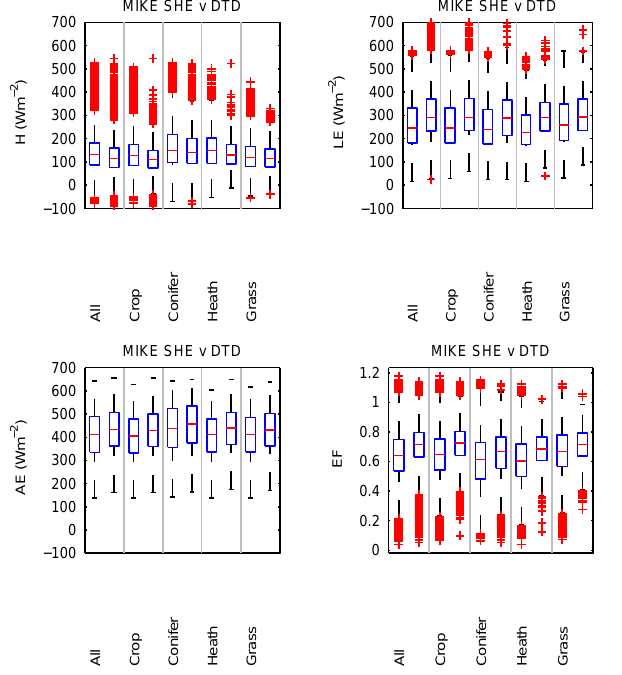
Figure 8. Box plots of sensible heat flux (top left), latent heat flux (top right), net radiation (bottom left) and evaporative frac- tion (bottom right) modelled by MIKE SHE (leftward box in each category) and DTD (rightward box in each category) and split by land cover class. The red horizontal line indicates the median value with the upper and lower box edges indicating the 75th and 25th percentiles respectively. The whiskers extend to the furthest point within 1.5 times the inter-box range above or bellow the box edges with points beyond that categorized as outliers and marked individ- ually as a red crosses.